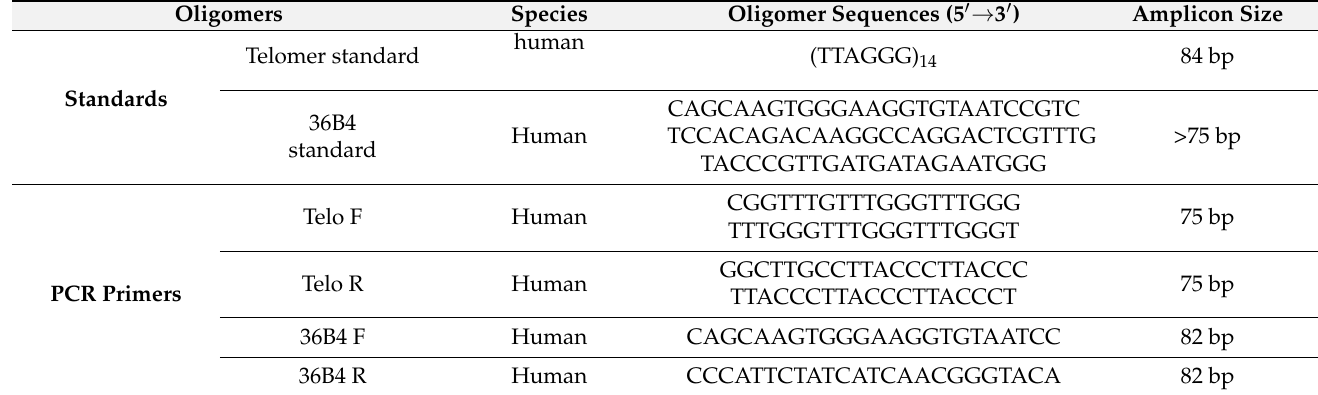
Table 1. Primers and their sequences used to determine telomere length